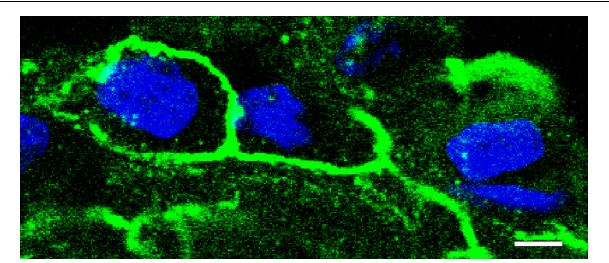
FIGURE 3 | Detection of tight junction proteins in pleural cells. Immunostaining of occludin with anti-occludin (green), detected by confocal laser scanning microscopy reveals a honeycomb-like distribution of tight junctions in pleural cells (visceral pleura, typical experiment, nuclei stained in blue, bar: 5 μ m).